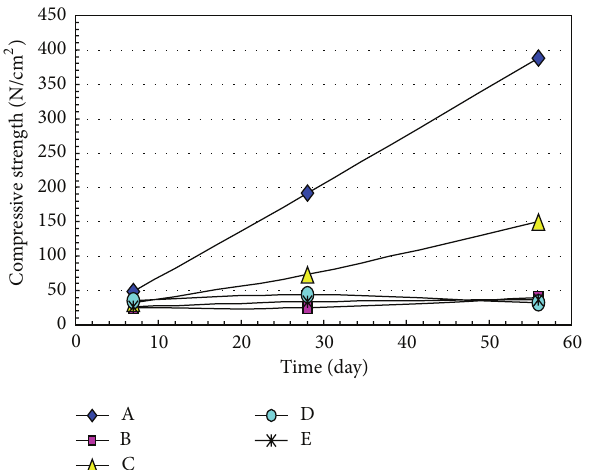
Figure 10: Unconfined strength of compacted soil.